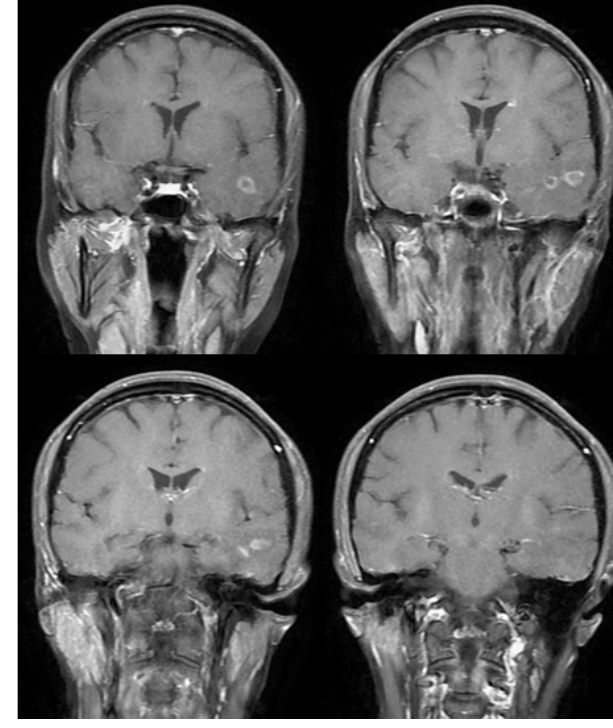
Figure 2. Coronal T1-weighted image with contrast revealed two open-ring enhancements in the right temporal lobe